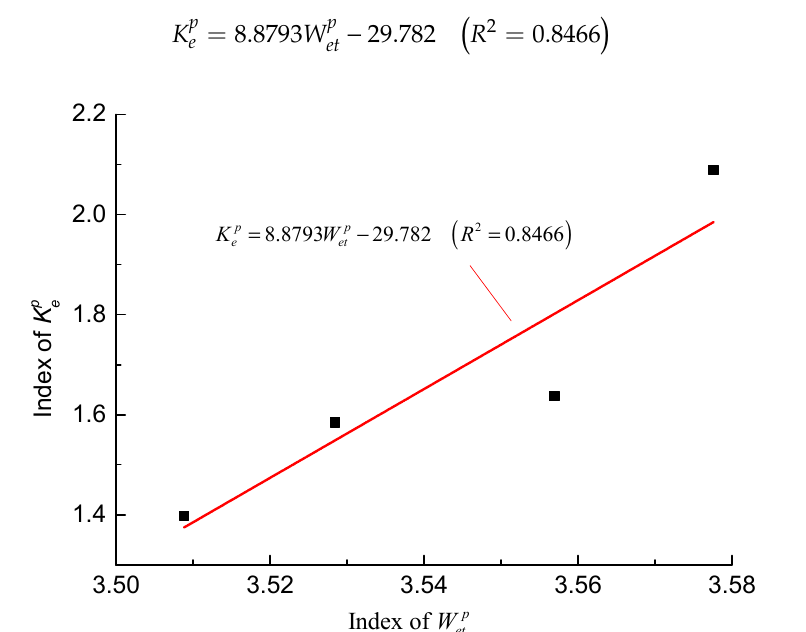
Figure 14. Relationship between indexes K p e and W p